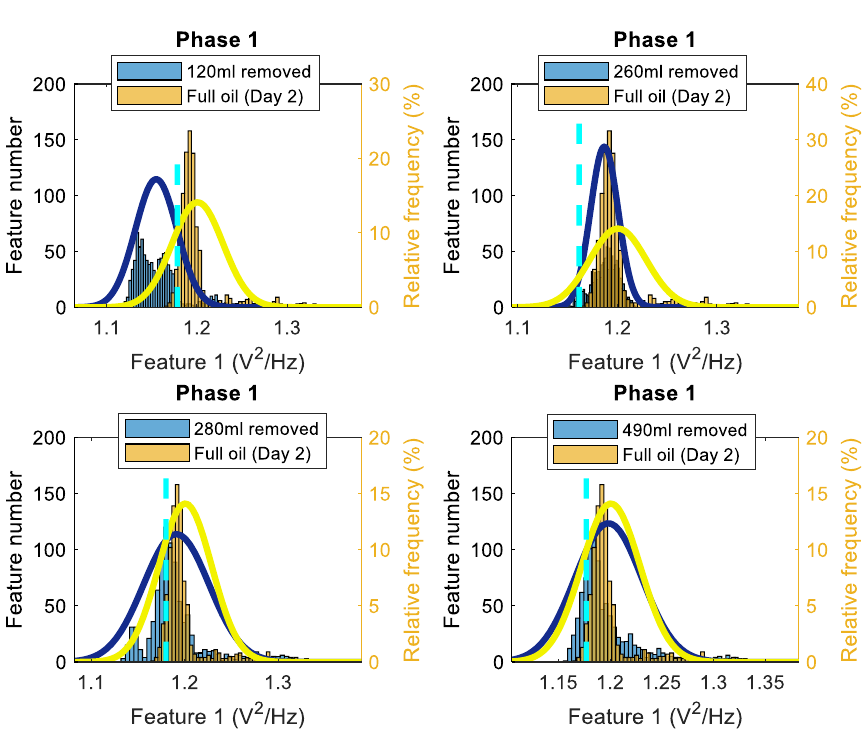
Figure A1. Histograms of Feature 1 (the first harmonic of the supply frequency) for phase 1 of the current signals, comparing the standard oil level (Day 2) to 120 mL, 260 mL, 280 mL and 490 mL of removed oil cases.